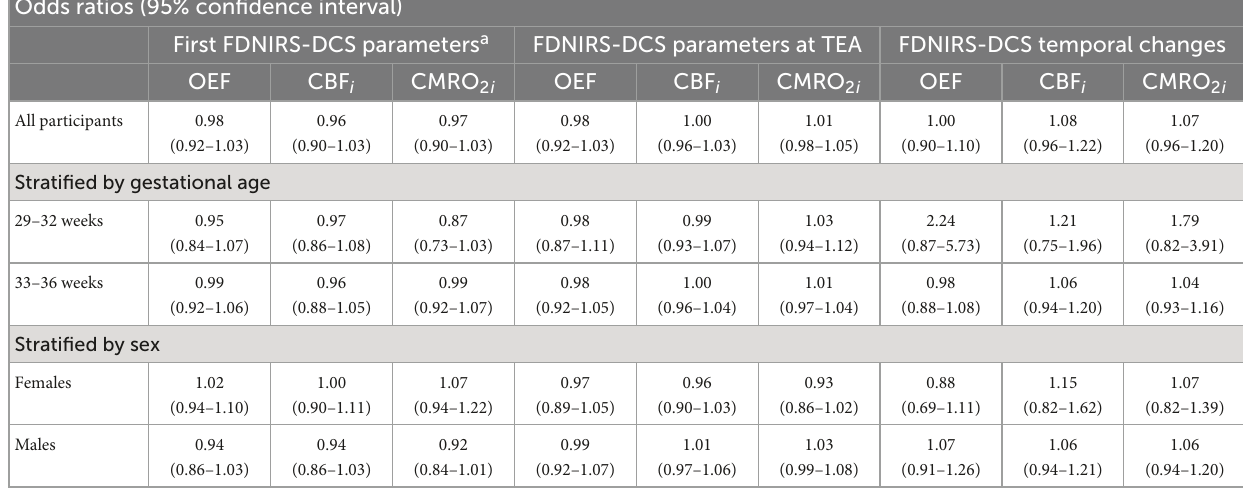
TABLE 2 Associations between FDNIRS-DCS parameters and temporal changes and neurological examination at term-equivalent age. Odds ratios (95% confidence interval) First FDNIRS-DCS parameters a FDNIRS-DCS parameters at TEA FDNIRS-DCS temporal